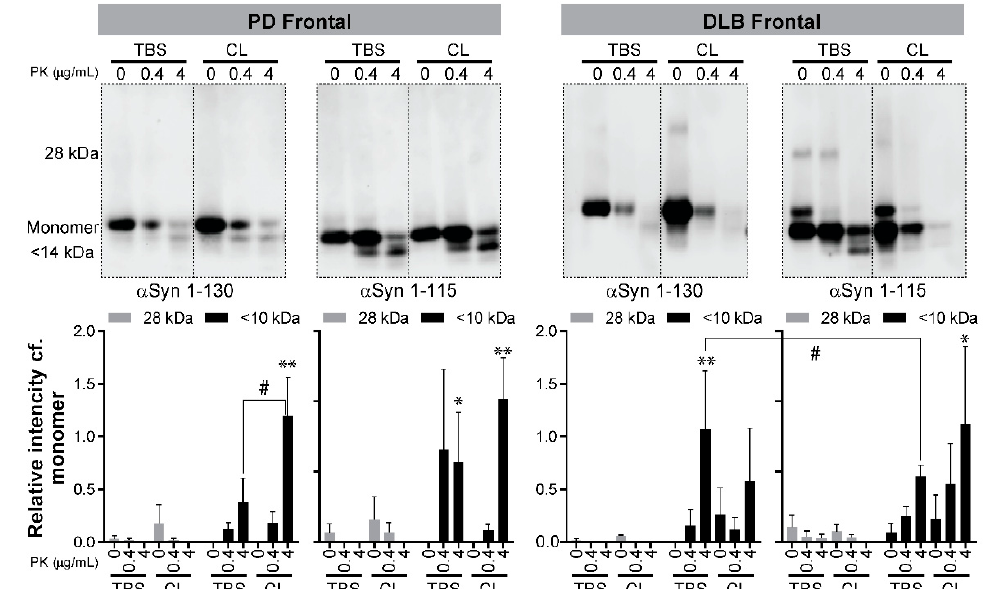
Figure 4. PK digestion of RT-QuIC end products from the frontal cortex of PD and DLB cases. The RT-QuIC end products (as described in Figures 2 and 3) were collected and incubated at 37 ◦ C with increasing concentrations of PK (0, 0.4, 4 µ g/mL). The figure shows two panels where in each panel a representative immunoblot is shown for RT-QuIC PK digestion reactions, and a bar graph summarizing immunoblot quantification (mean + SD) from three cases for each condition. Immunoblots were quantified using ImageJ to calculate the intensity of aggregates (28 kDa) and PK-digested products (< 14 kDa) relative to the intensity of the monomeric α Syn in each lane. Statistical analysis was performed with GraphPad Prism using two-way ANOVA with Tukey’s post-test. Asterisks denote significant differences within a condition (* p < 0.05, ** p < 0.01) and hashtags denote differences across groups (# p < 0.05). Higher exposures of the blots are shown in Supplementary Figure S3 to show the high-molecular weight bands corresponding to α Syn aggregation.